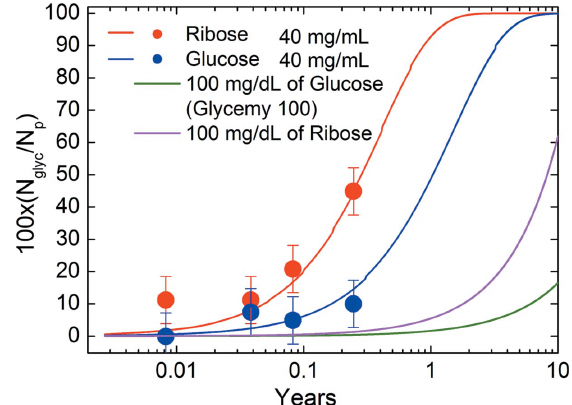
Figure 11 Percentage of glycations, predicted by Equation (5), as a function of the incubation time, calculated using the glycation probability according to Equation